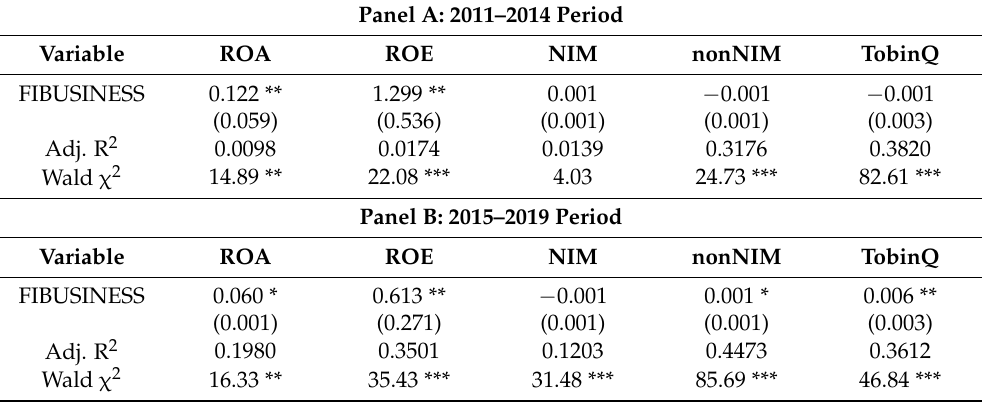
Table 6. The effect of financial innovation on bank performance considering endogeneity.